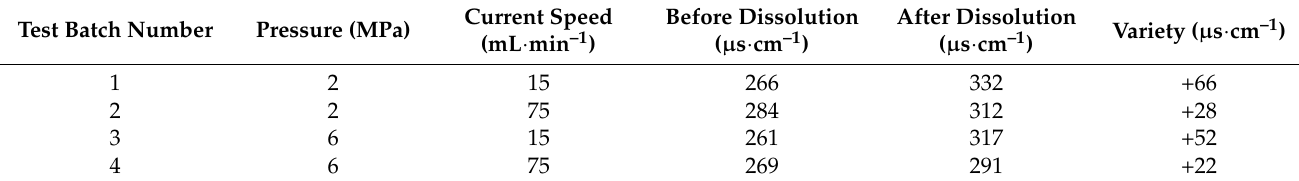
Table 5. Solution conductance data under four groups of test conditions.